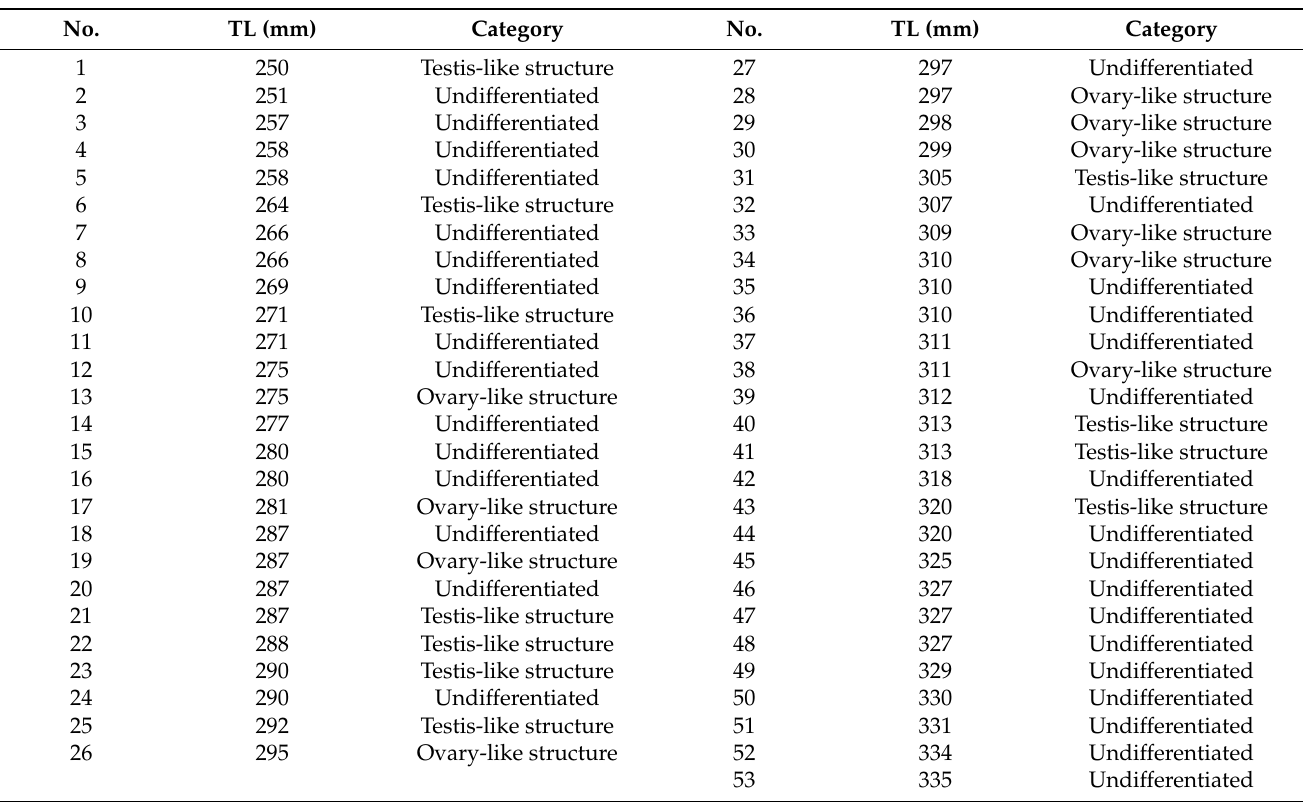
Table 5. Undifferentiated gonad samples of Japanese eel used to